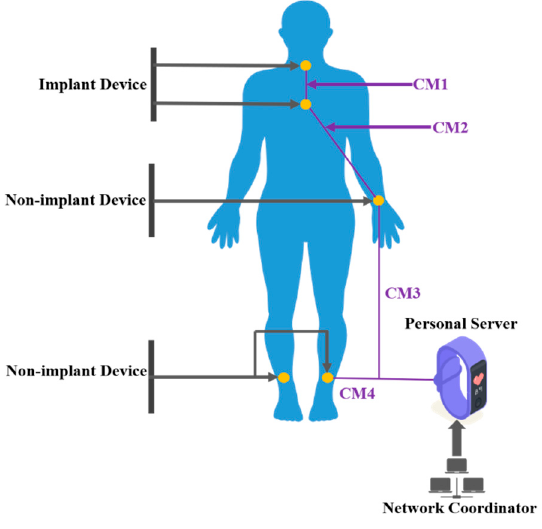
Table 9. Descriptions of IEEE 802.15.6 channel models. Data from Ref. [82].